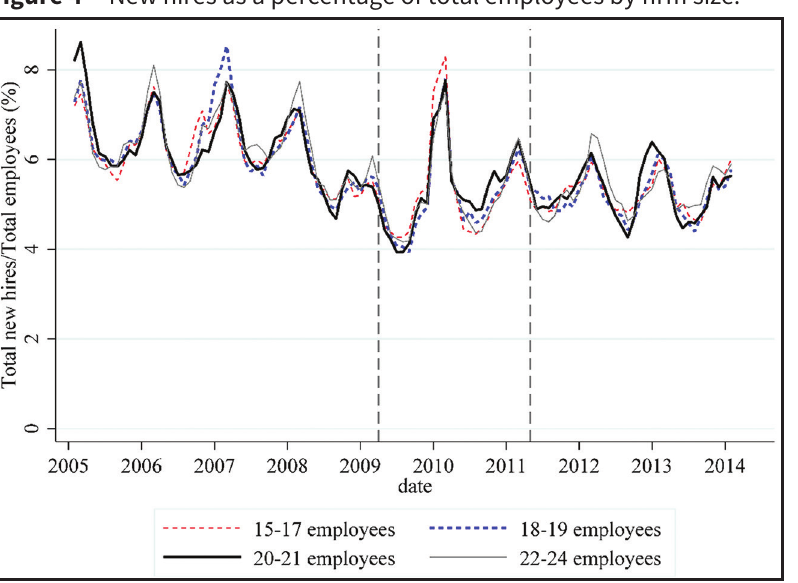
Notes : Values are 3-month moving averages. Vertical gray lines indicate the policy 29 Three-month moving averages are presented for ease of viewing.